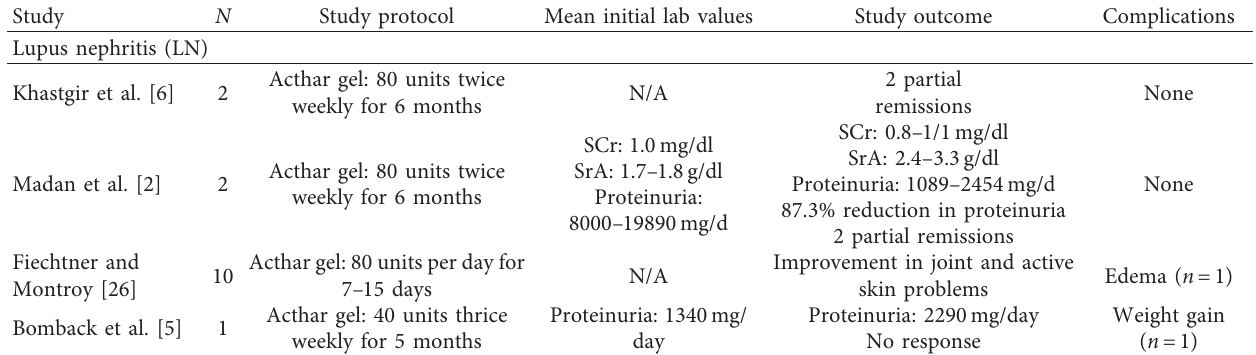
Table 8: Summary of studies on ACTH in lupus